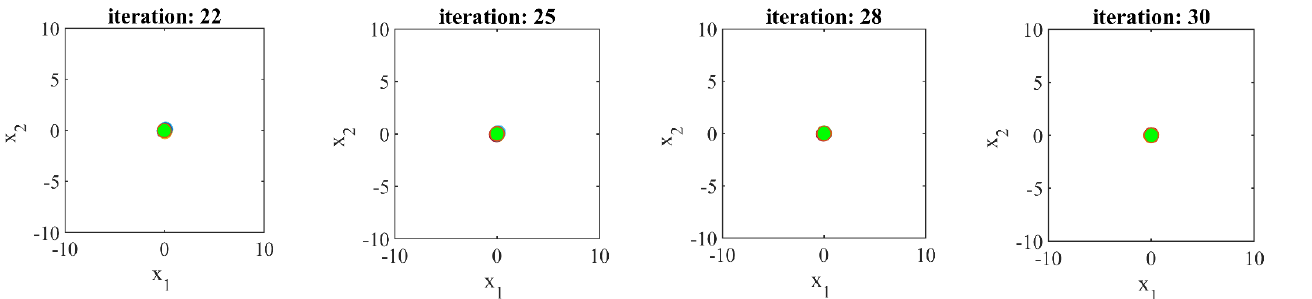
Figure 2. Visualization of the movement of SSVUBA members towards the solution in the search space.